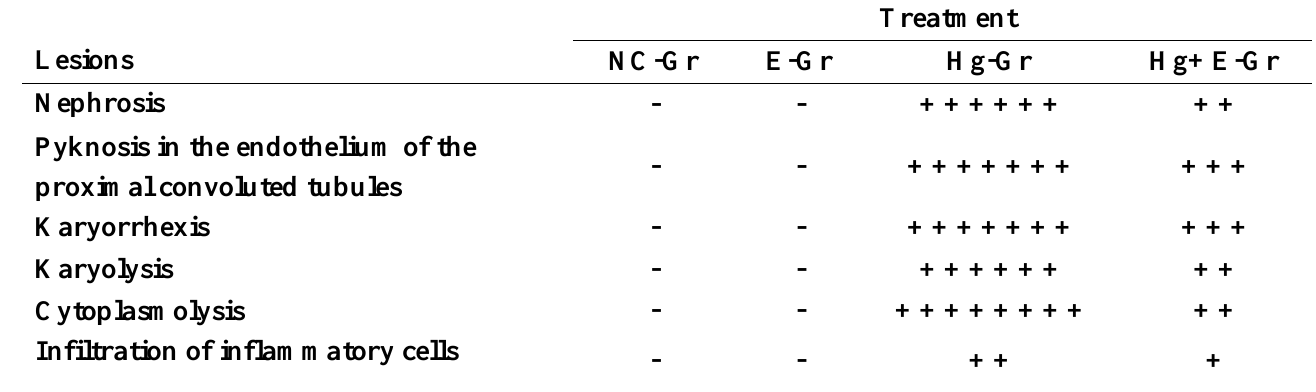
Table 3. Histopathologic scoring lesions in kidneys of Control Negative Group (CN-Gr), vitamin E treated Group (E-Gr), HgCl 2 intoxicated Group (Hg-Gr) and HgCl 2 +vitamin E treated Group (Hg+E- Gr ) at the end of the experimental